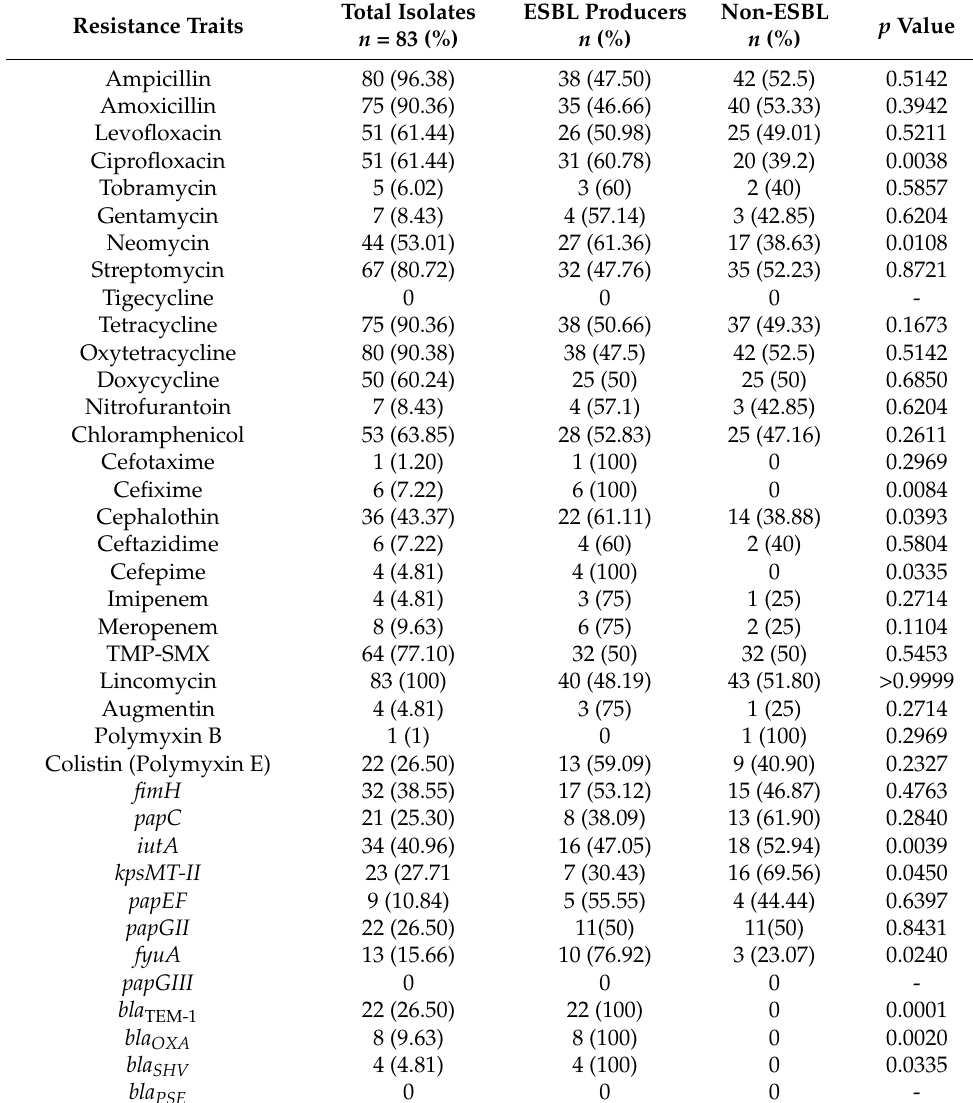
Table 2. Comparison of antibiotic resistant traits of ESBL producing E. coli isolates ( n = 83). p values were calculated by chi-square test.